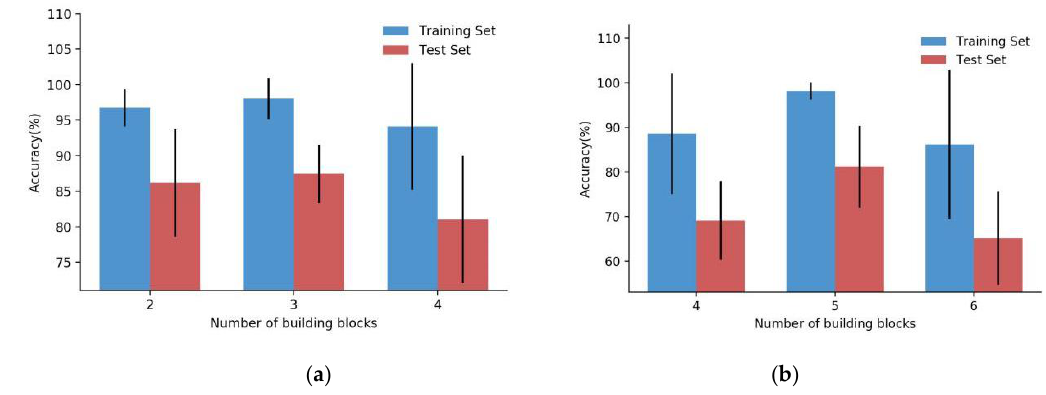
( b ) Figure 13. Comparison of accuracy with different numbers of intermediate layers by LCCDNNs. ( a ) C. elegans dataset, ( b ) zebrafish dataset. ( a ) ( b ) Figure 14. Comparison of accuracy with different numbers of intermediate layers by FCCDNNs. ( a ) C. elegans dataset, ( b ) zebrafish dataset. 4.3.3. Accuracy Analysis of Different Numbers of Building Blocks In this experiment, the performance comparison of different numbers of building blocks in the LCCDNN and FCCDNN models was tested for solving the neuronal morphology classification problem. Figure 15 shows the classification results with different numbers of building blocks in the LCCDNNs. The number of building blocks in the deep neural network was increased, while the other settings remained the same. Figure 15a shows the classification accuracy in the C. elegans dataset and Figure 15b shows the classification accuracy in the zebrafish dataset. With the increase in the number of building blocks, the classification accuracy increased. However, when the building block number increased further, the classification accuracy decreased gradually. Figure 16a shows the variation of FCCDNN accuracy in the C. elegans dataset, when the number of building blocks was 3, 4, and 5, the accuracy of the training set was 97.45%, 96.86%, and 93.012%, and the accuracy of the test set was 83.33%, 82.82%, and 80.26%, respectively. Therefore, when the